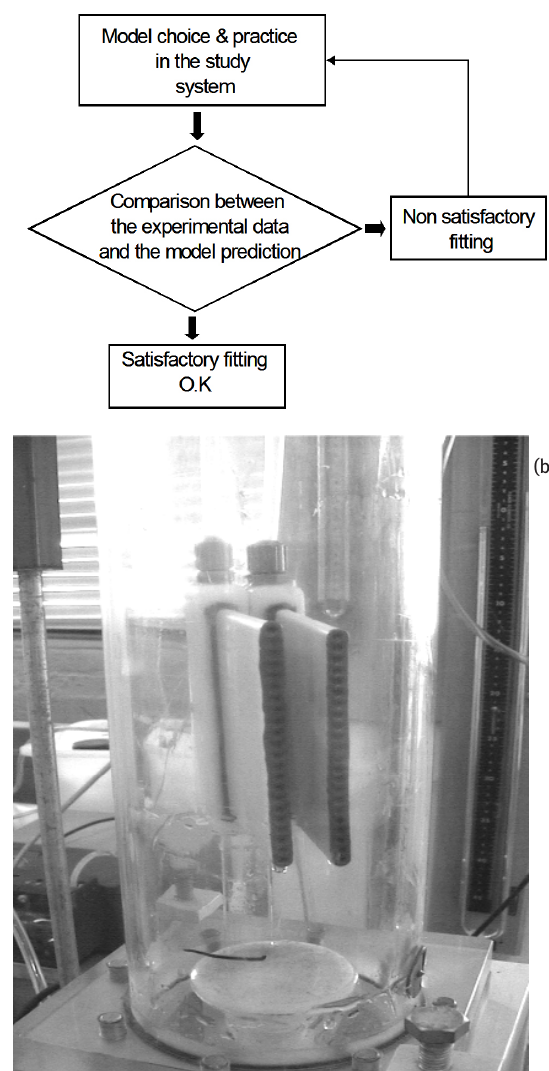
Figure 2: (a) Conductivity measurements and (b) RTD calculations in the hybrid cell; ( L / D = 8) QL = 15.82 cm 3 min -1 , Qg = 4456 cm 3 min -1 , hL = 84 cm, τ = 417 Figure 3 : (a) Characterization of flow patterns in the flotation- theoretical membrane hybrid system: logic of RTD measurements. (b) A close- view photograph of the hybrid cell. Figs. 1b and 2b compare the mean experimental data and theoretical curves for N = 1 in the tanks-in-series model, for small ( h = 41.2 cm) and large columns ( h = 84 cm). In L L both cases, the experimental data are well described by the theoretical curve; both systems behave as well-mixed vessels.